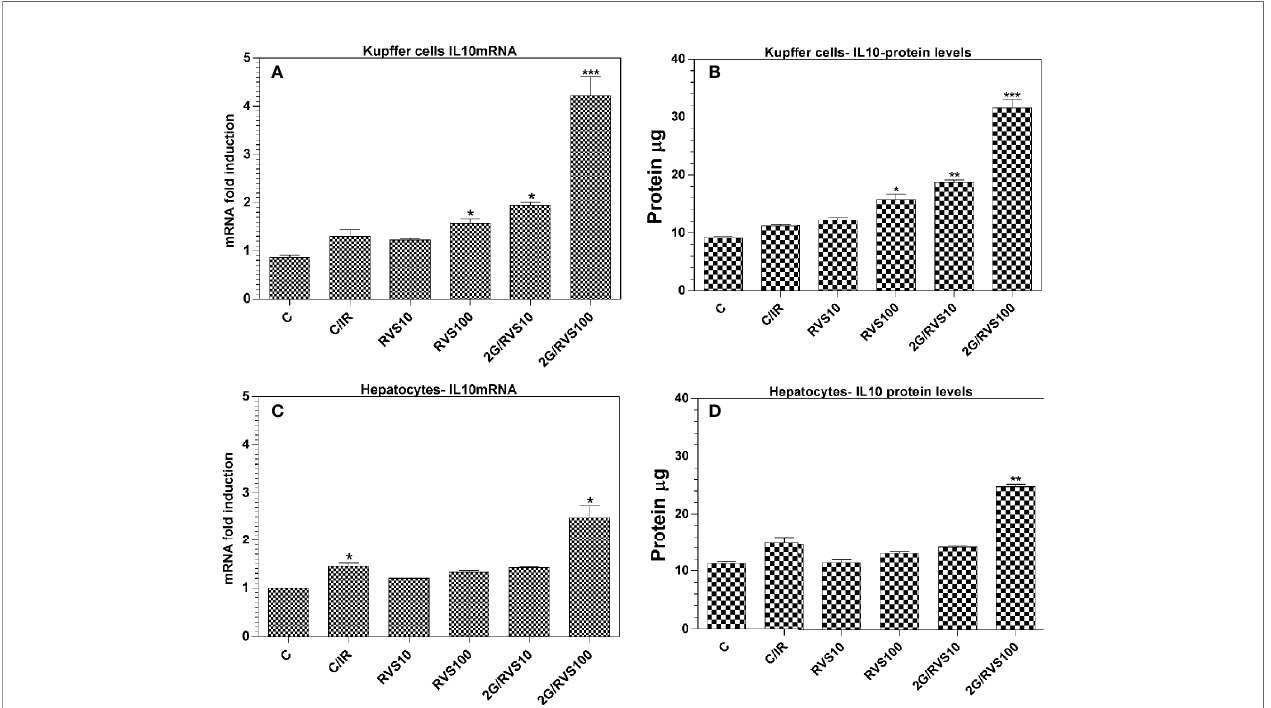
FIGURE 4 | Effects of a 2 Gy single dose of whole body irradiation and RSV on IL10 relative mRNA gene expression and protein levels in Hepatocytes (A , C) and Kuppfer cells (B, D) of Wistar rats. (C, control group; C/IR, irradiated rats, RSV10 and RSV100; irradiated rats with 2 Gy pretreated with resveratrol 10 mg 100 mg/ kg body weight, respectively). C/IR are compared to C; RSV10 or RSV100 are compared to C; 2G/RSV10 or 2G/RSV100 are compared to C/IR. *p < 0.05, **p < 0.01, ***p <